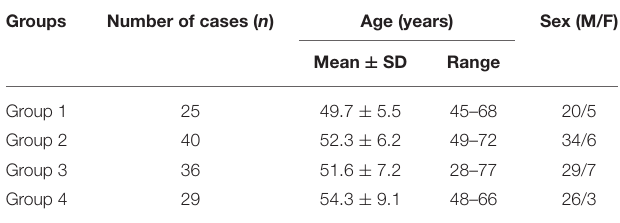
TABLE 1 | Demographic characteristics of the FAS